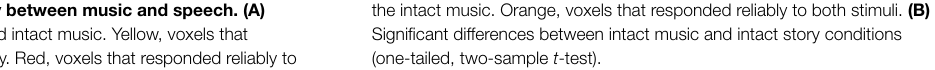
the intact music. Orange, voxels that responded reliably to both stimuli. (B) Significant differences between intact music and intact story conditions (one-tailed, two-sample t